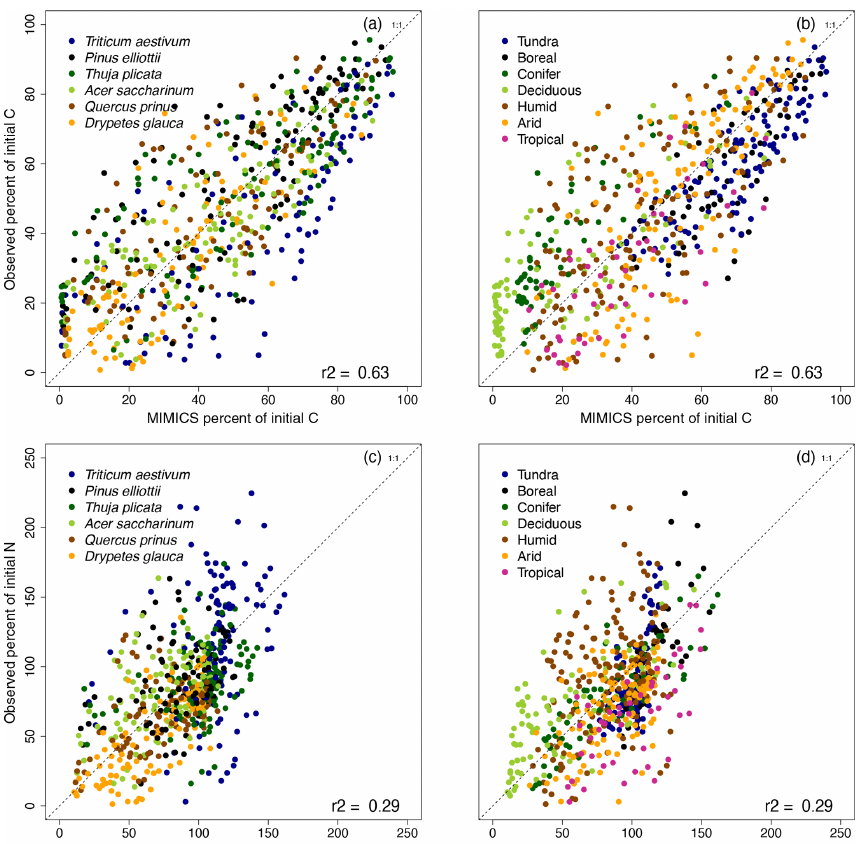
Figure 3. MIMICS-CN simulations of percent (a, b) C remaining and (c, d) N remaining in litterbags in the LIDET study versus observed values, colored by (a, c) litter type or (b, d) biome. Dashed line shows the 1:1 line.